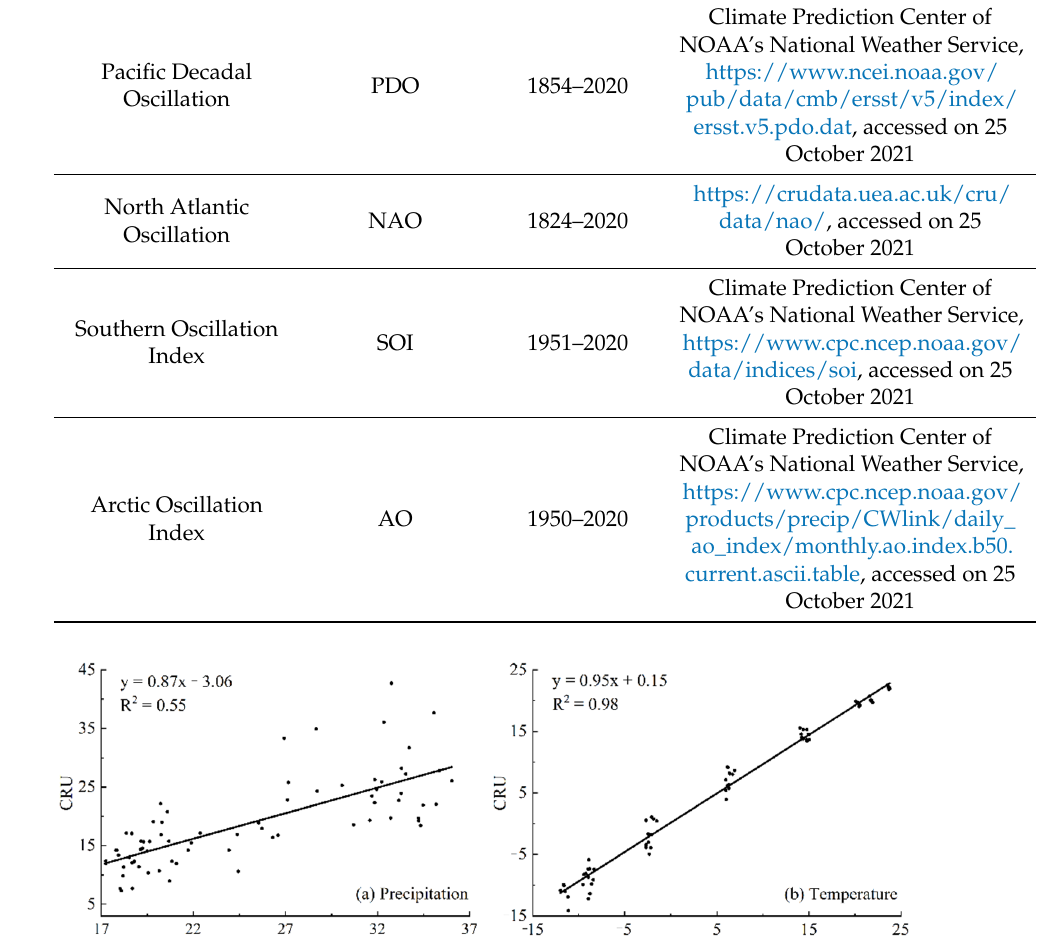
Figure 2. Comparison of precipitation ( a ) and temperature ( b ) between CRU and multi-model en- semble data from 2015 to 2020. ensemble data from 2015 to